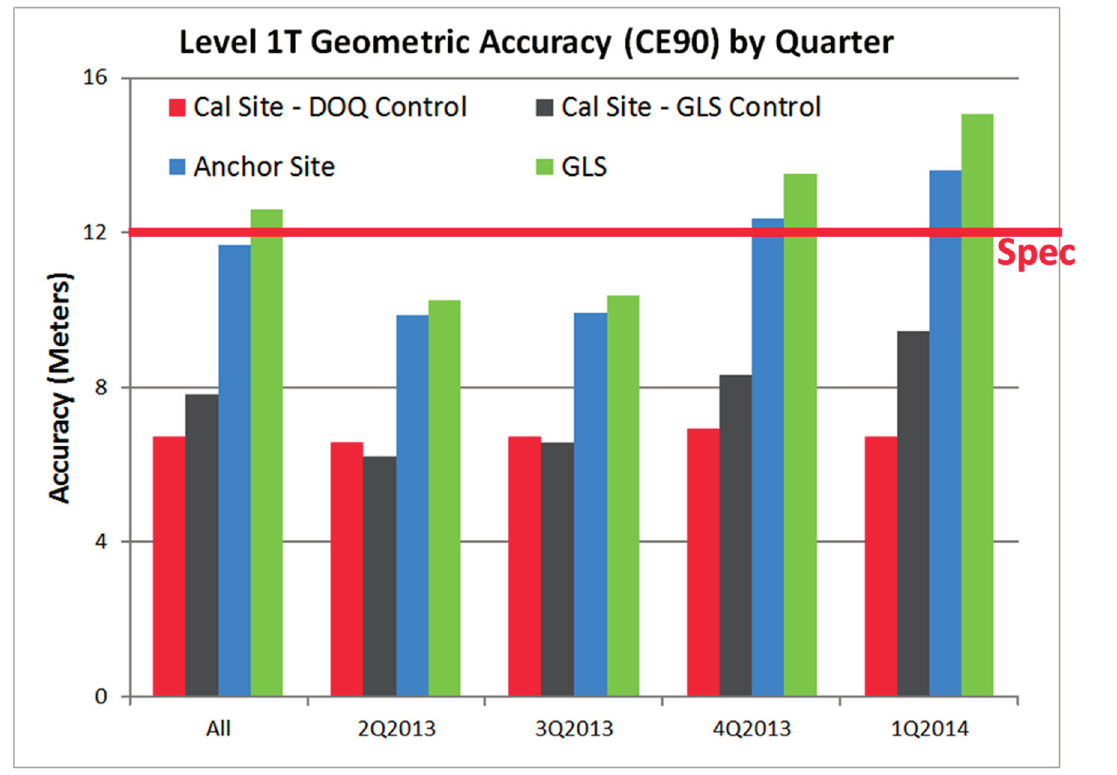
Figure 9. Level 1T product accuracy by calendar quarter. The accuracy estimates are highly sensitive to the quality of the ground control used to measure the